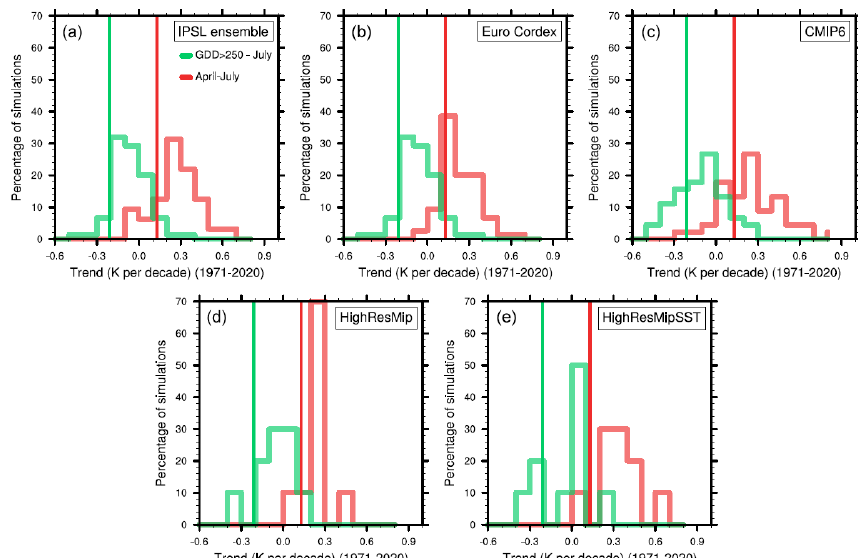
Figure 5. Histogram of the daily minimum temperature trend calculated from (a) the IPSL ensemble, (b) the EURO-CORDEX ensemble, (c) the CMIP6 ensemble, (d) the HighResMip ensemble and (e) the HighResMipSST ensemble (see Sect. 4.1 and the Supplement for more details about these ensembles). The observations are represented with the vertical lines. The trends are calculated over the 1971–2020 period for (green) GDD > 250 and (red) from April to May.